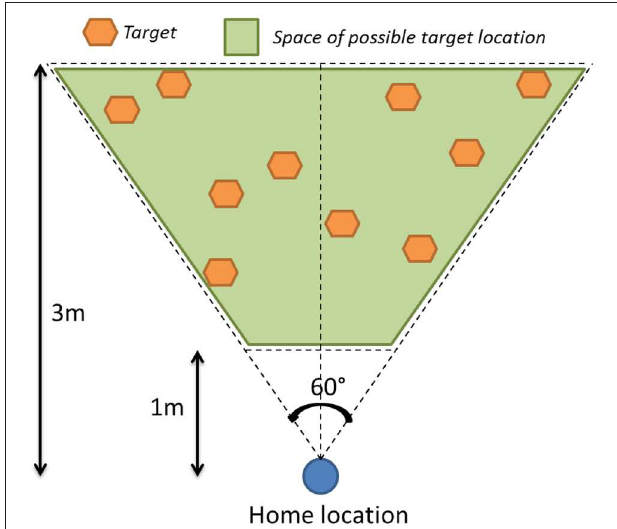
FIGURE 9 | Example of 10 targets defined for one condition.